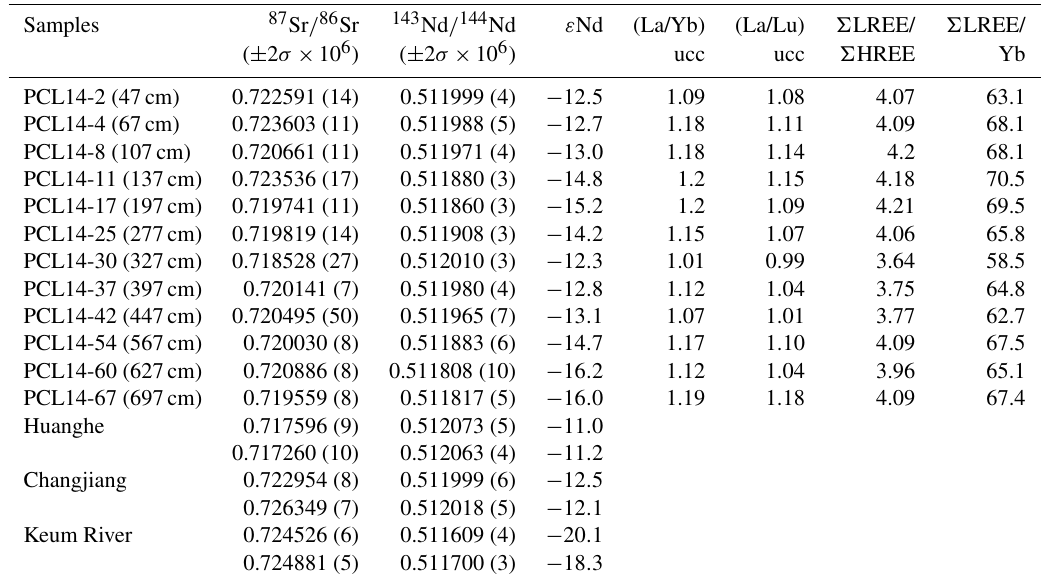
Table 3. Isotopic and geochemical data of core PCL14 and riverine samples.